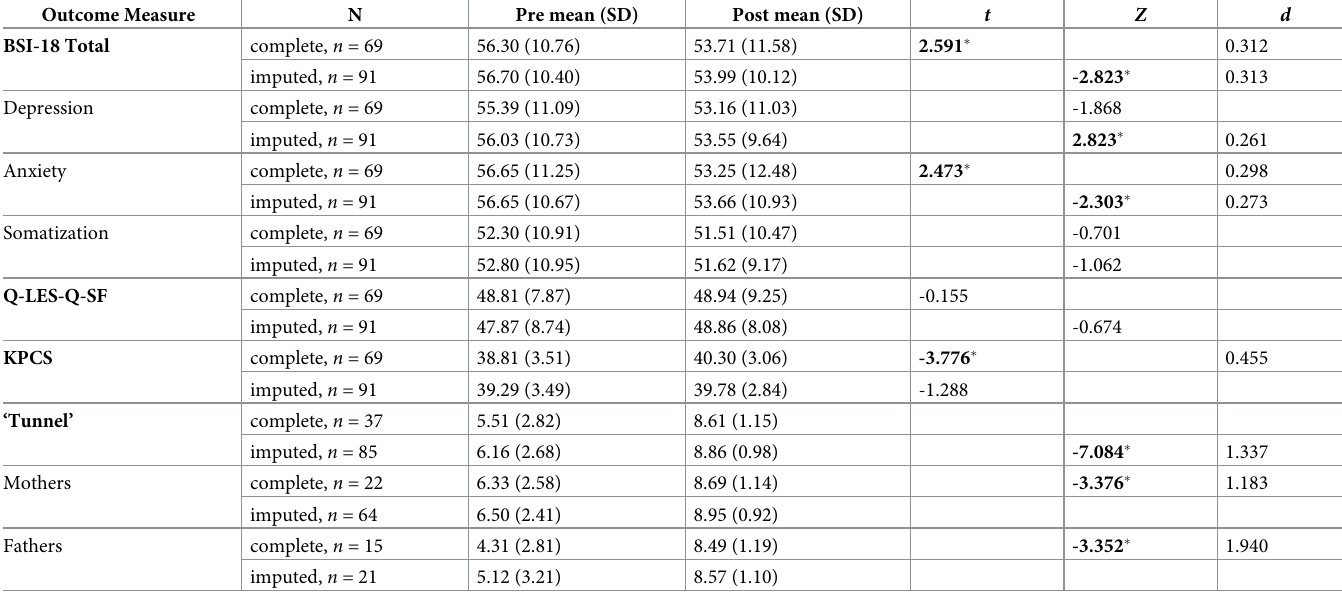
Table 2. Mean pre-and post-group scores for all outcome measures for the completer sample and imputed dataset. Outcome